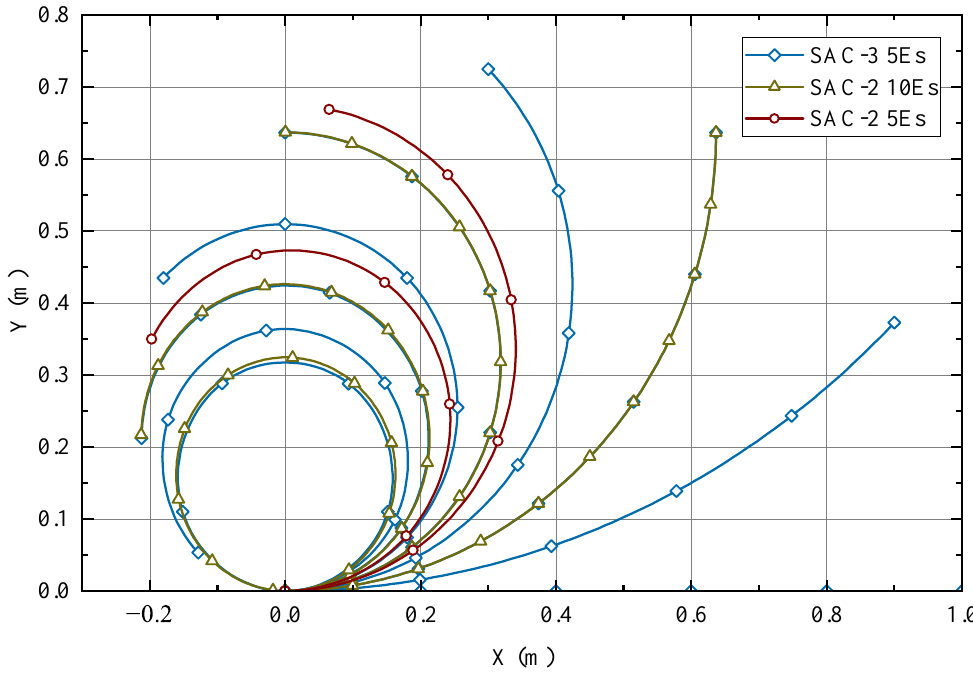
Figure 3. The circle-bending example with 5 and 10 SAC-2 elements and 5 SAC-3